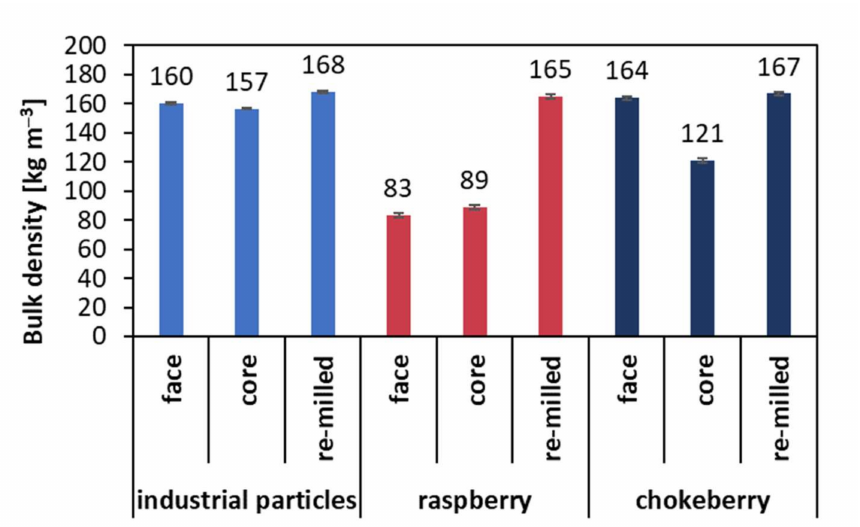
Figure 4. Bulk density of particles used to produce composites, considering the particles produced by the re-milling of